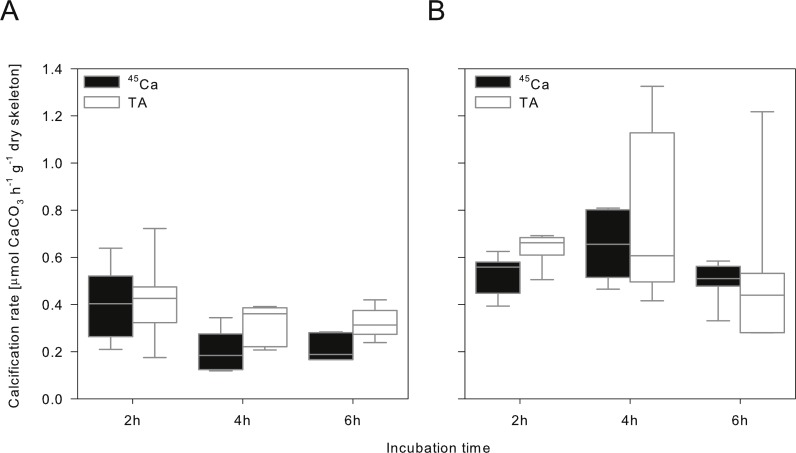
Calcification rates.Calcification rates of the same Stylophora pistillata colony at (A) pHT 8.1 and (B) pHT 7.5 derived from different incubation intervals and measurement techniques (45Ca uptake vs. TA) as boxplots with median line (N = 6; technical replicates).